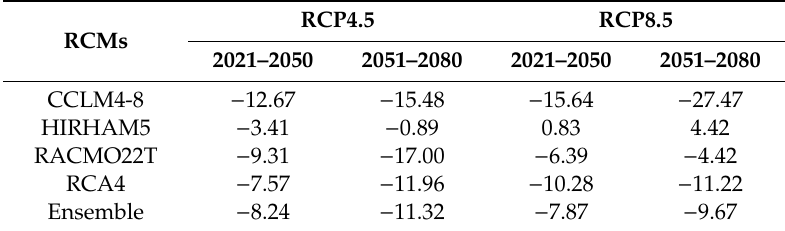
Table 4. Changes in precipitation (%) across the four RCMs in RCP4.5 and RCP8.5 scenarios.